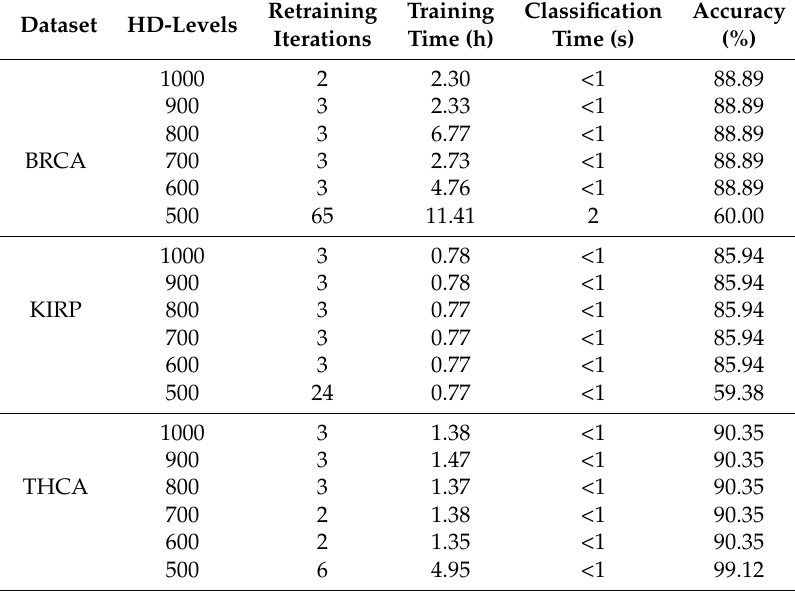
Table 5. Benchmarks of the HD classification algorithm performances with different amounts of HD-levels and HD vector dimensionality fixed to 1000 and 100 maximum retraining iterations. The best result achieved by the HD-classifier after the number of retraining iterations is shown.